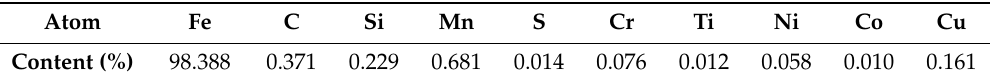
Table 1. Chemical composition of the studied mild steel (MS).